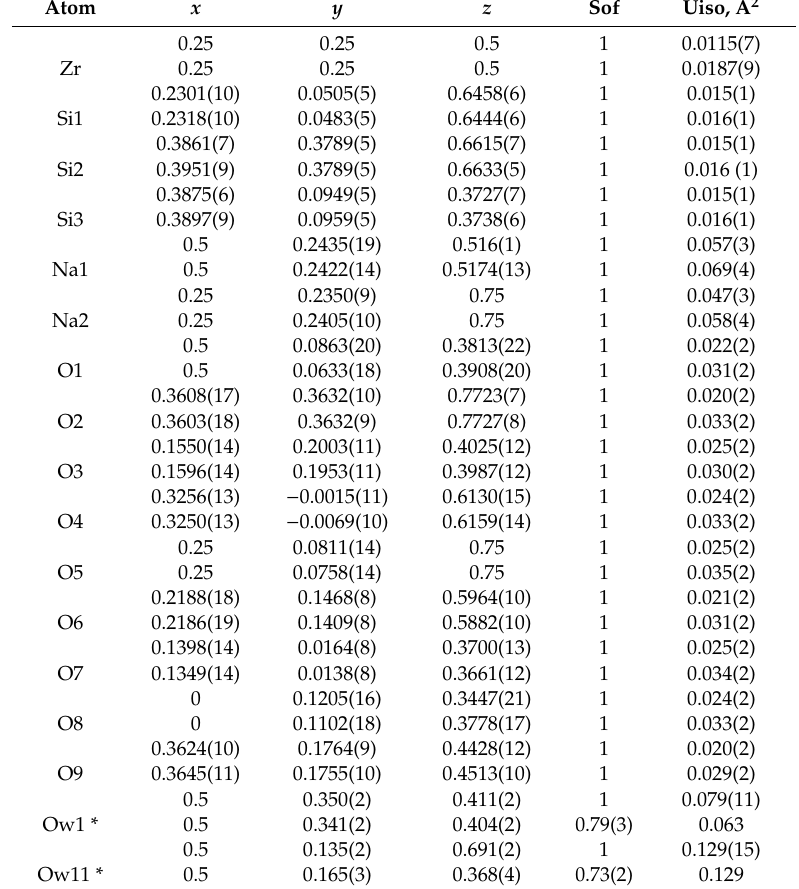
Table 3. Positional and thermal parameters of the atoms in the structure of elpidite ( Cmce ) heated at 90 ◦ C (first line of each row) and at 165 ◦ C (second line), as obtained from the in situ time-resolved PXRD